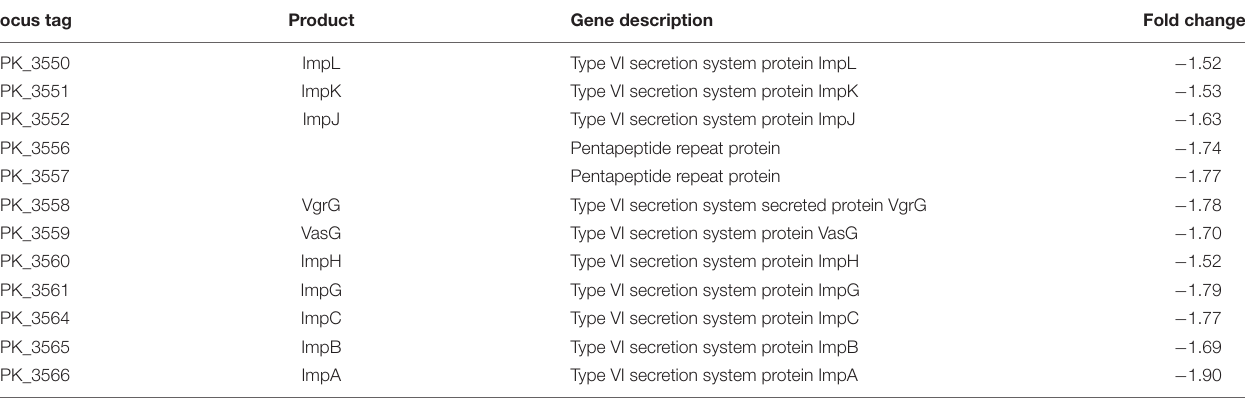
TABLE 2 | T6SS4 genes regulated by HpaR in Y. pseudotuberculosis. Locus tag